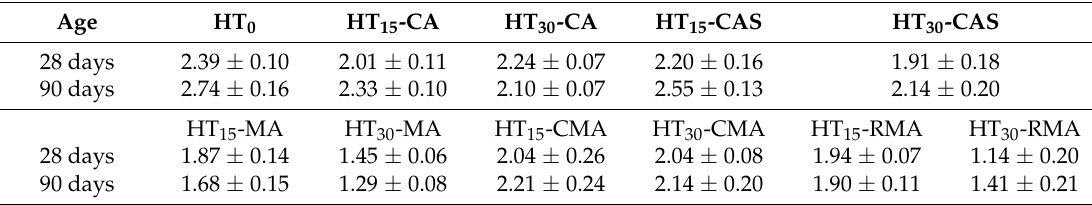
Table 8. Results of flexural resistance (kN), of hollow tiles, as a function of the aggregate type, dosaging method (see Table 5 for nomenclature), and